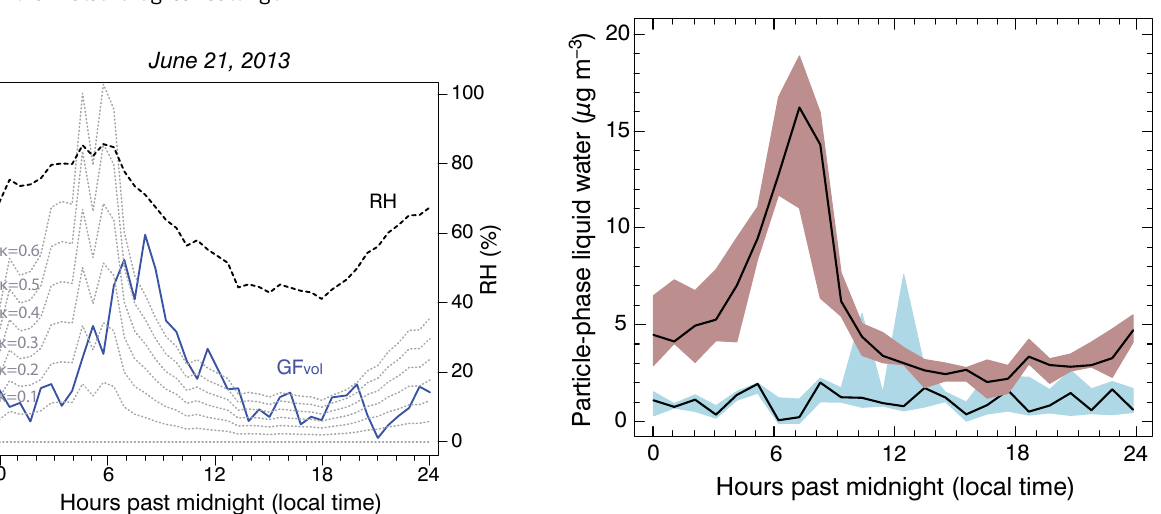
Figure A2. Comparison of particle-phase liquid water for a 5-day period with heavy rainfall (4–8 July, blue) vs. a 5-day period with no rainfall (18–22 June, brown). The central lines indicate the median, and the shaded regions indicate the interquartile